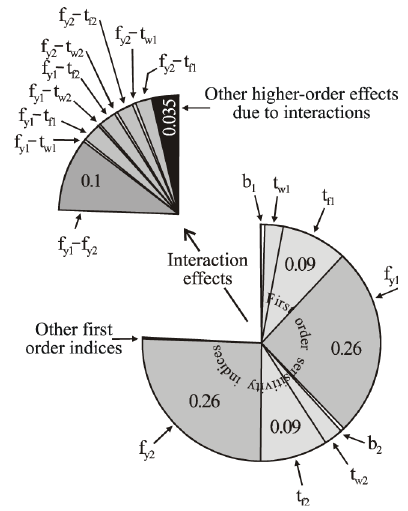
Fig. 5. Sensitivity analysis – Frame 1 and/or 2, h = 0